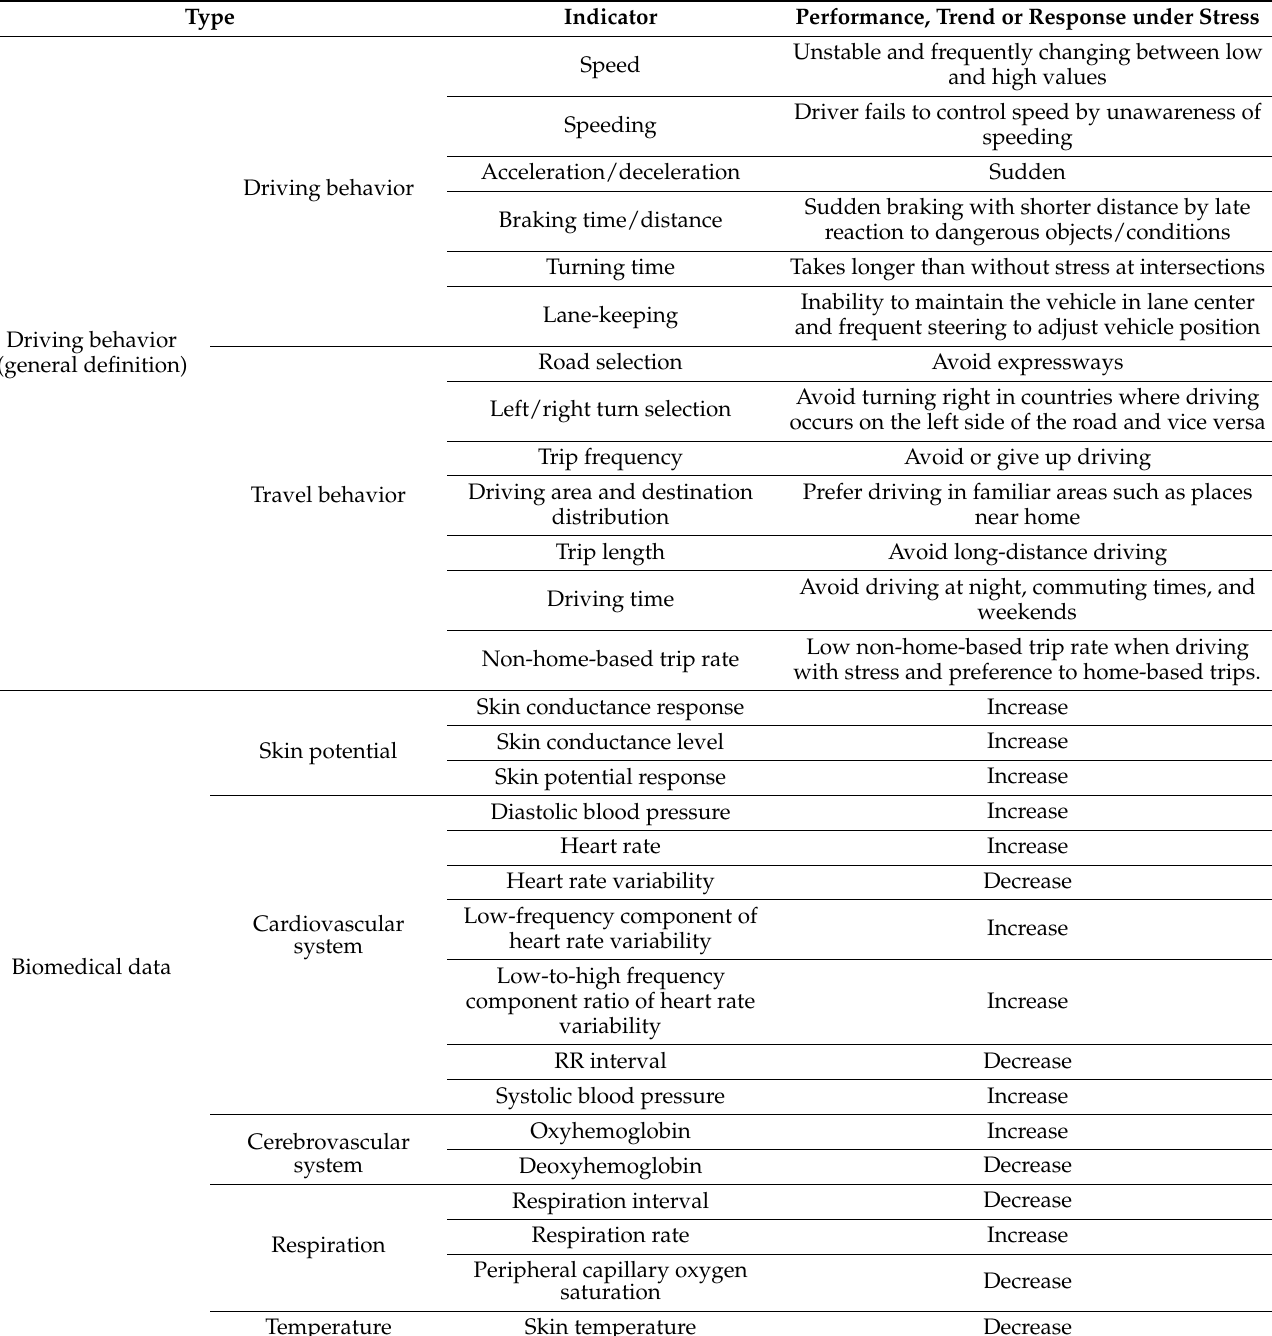
Table 6. Behavior indicators and biomedical indicators related to driving